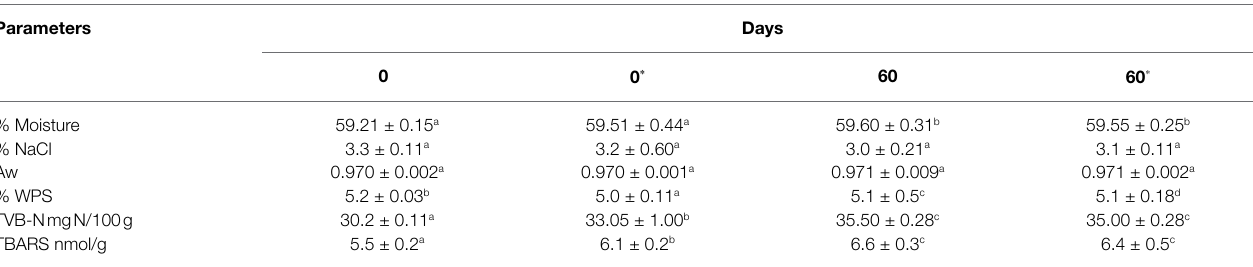
TABLE 5 | Physicochemical parameters in cold-smoked sea bass stored at 6 ± 2 ° C with * or without starters added.